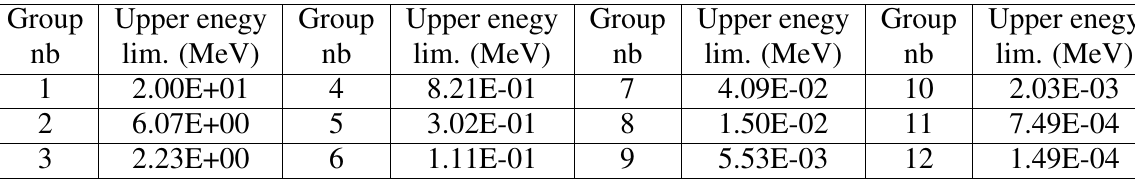
Table 1: 12-energy group